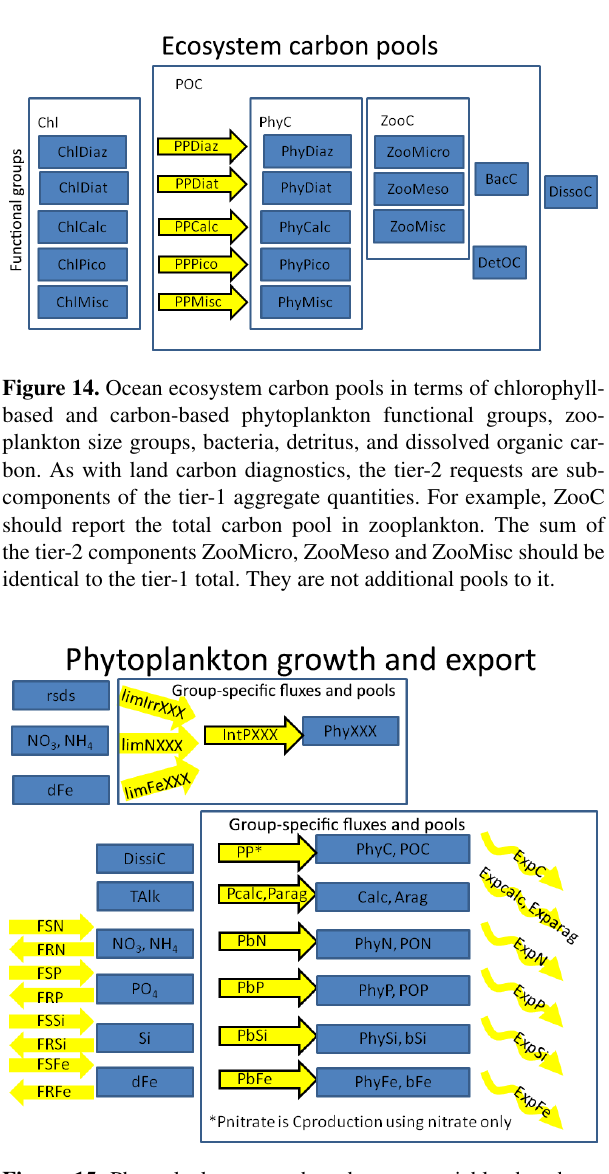
Figure 15. Phytoplankton growth and export variables by phyto- plankton group and by associated elemental cycle including exter- nal sources and removal. Export refers to the export flux due to sink- ing.